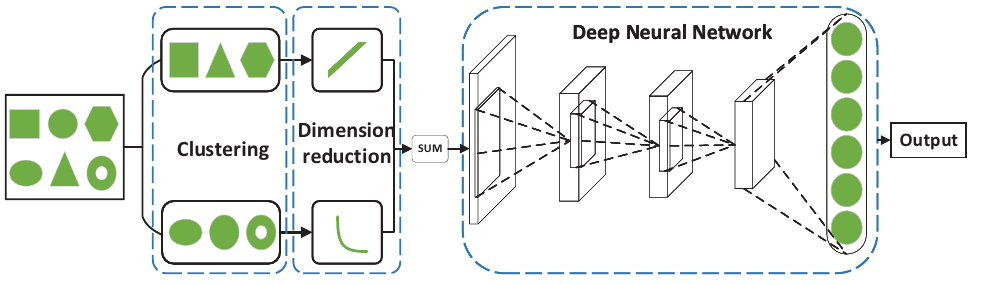
Figure 1. Architecture of the proposed anomaly detection